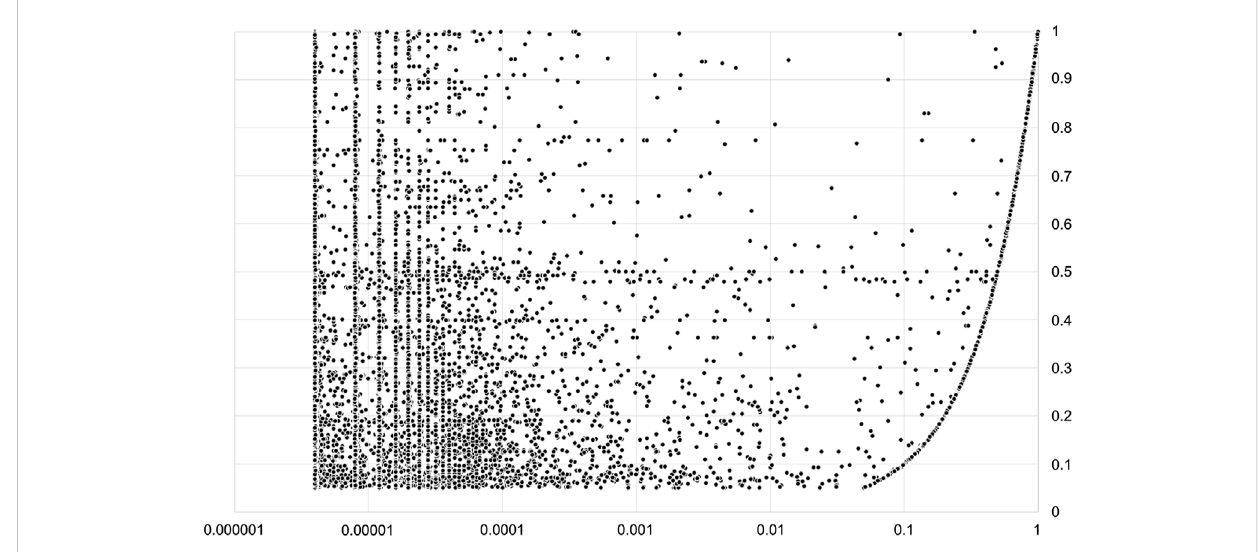
FIGURE 2 Variations localized in protein domains with a DOLPHIN frequency greater then 5% and reported in gnomAD. X -axis (logarithmic scale) = gnomAD frequency; Y -axis = DOLPHIN Frequency. Note that only a minority of variations (2.4%) have the same frequency in both